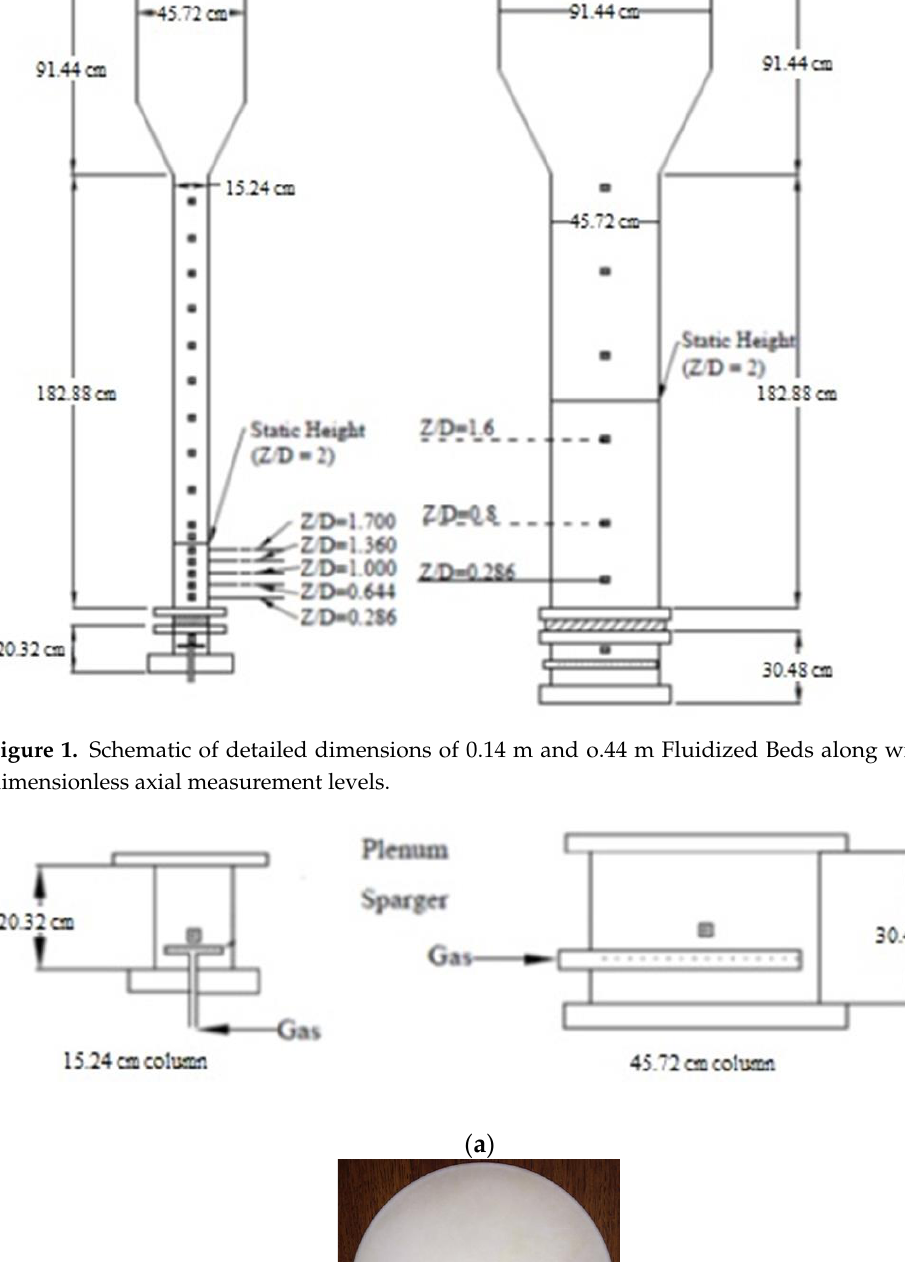
Figure 2. ( a ) plenum design ( b ) Distributor for 0.14 m and 0.44 m fluidized bds made of a porous Polyethylene sheet with a pore Size of 15 – 40 μm.